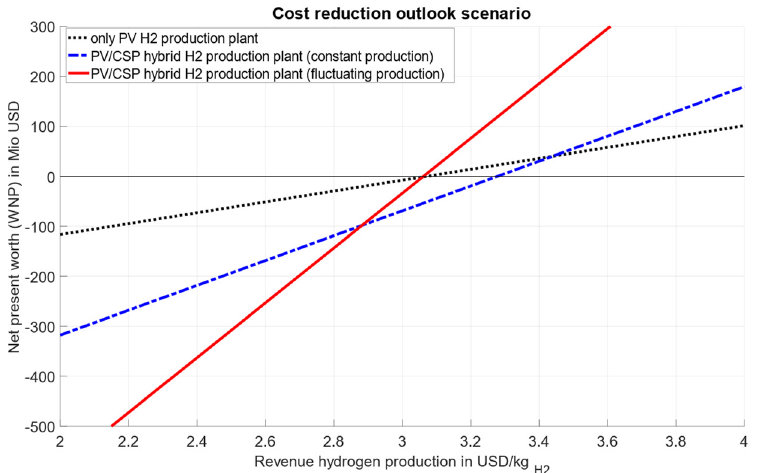
Figure 11. Net present worth (WNP) of the best solar hydrogen production plants depending on the revenue of the produced hydrogen (cost reduction outlook scenario).